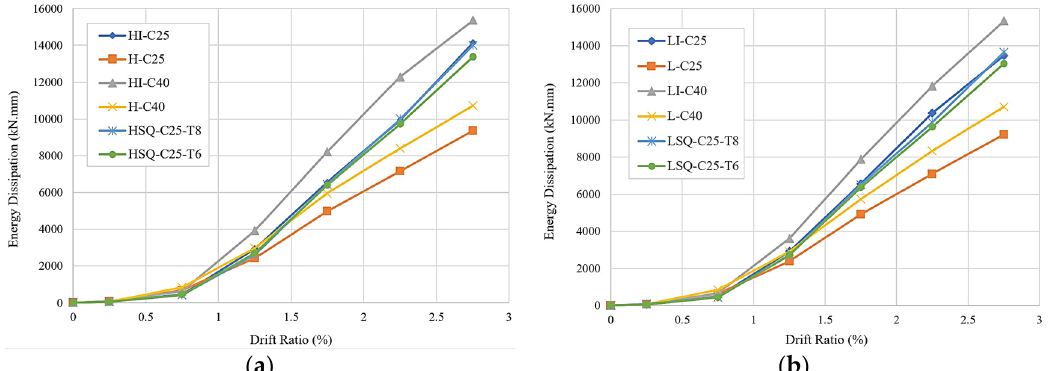
Figure 21. Energy dissipation curves of frame models: ( a ) HD; ( b ) LD.